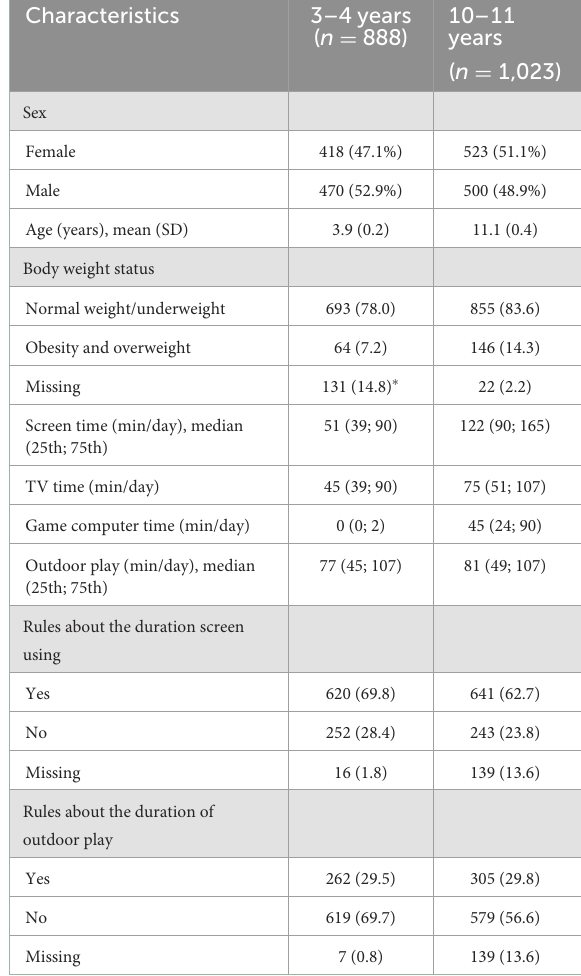
TABLE 1 Characteristics of the study population in the GECKO Drenthe cohort study.